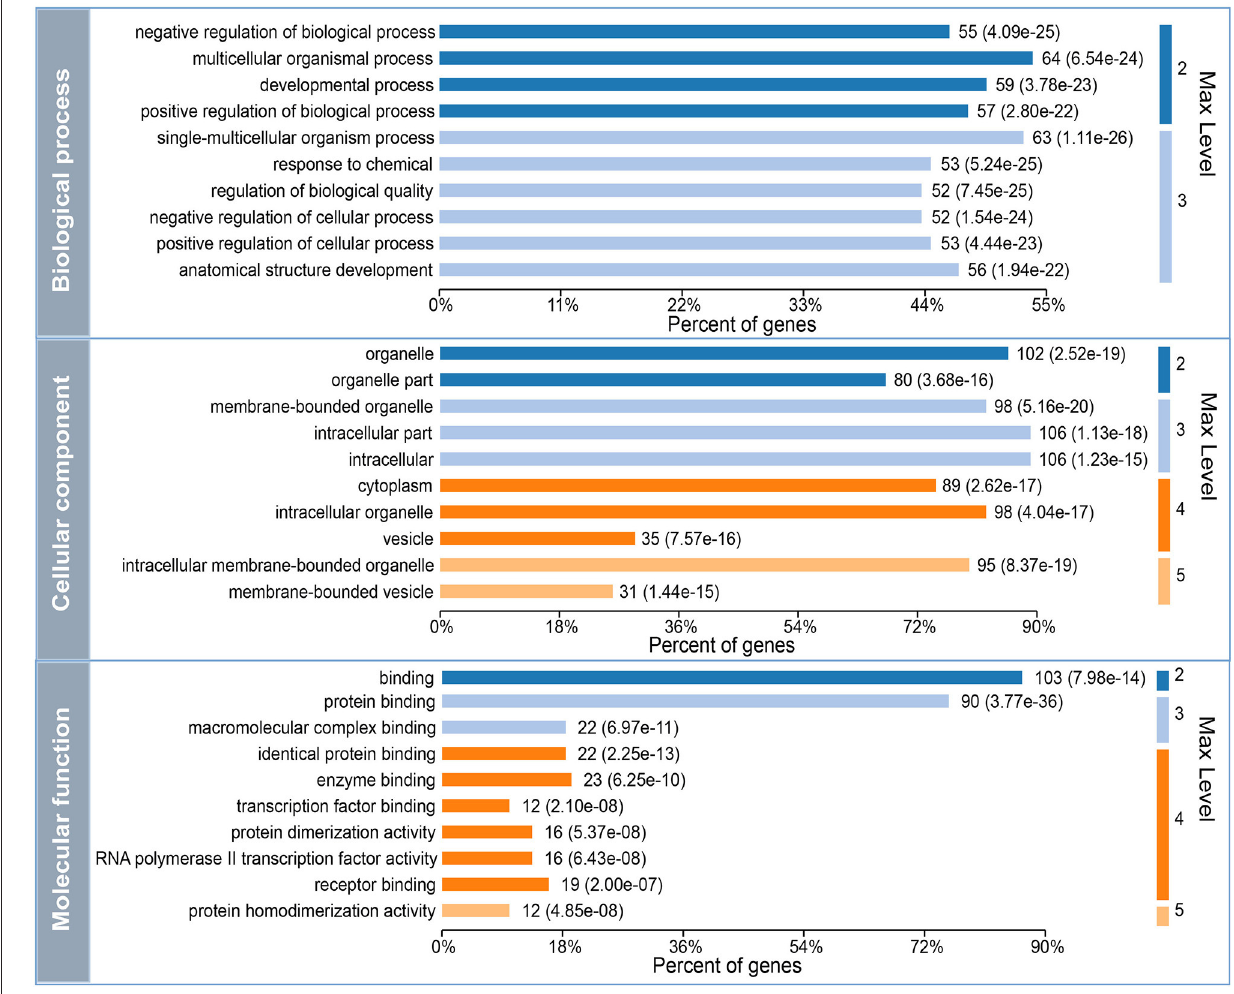
Frontiers in Psychiatry |